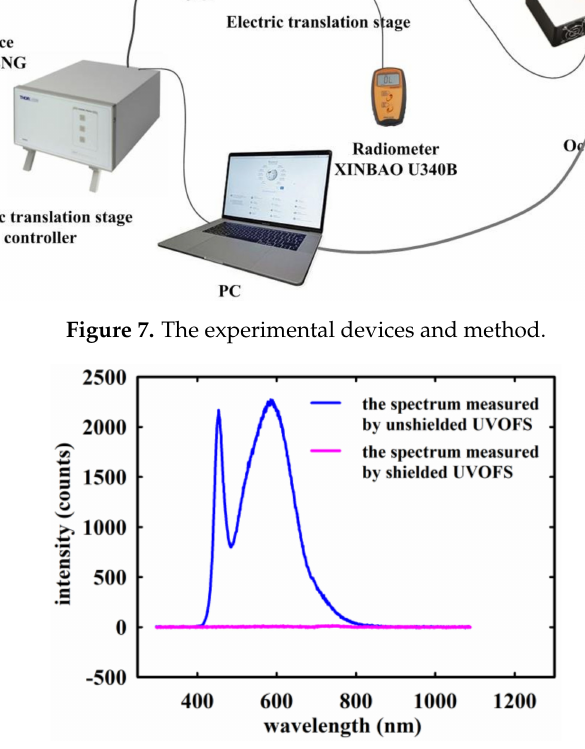
Figure 8. The comparison of the transmitted spectra from UVOFS without the shielding box and with the shielding box under visible light